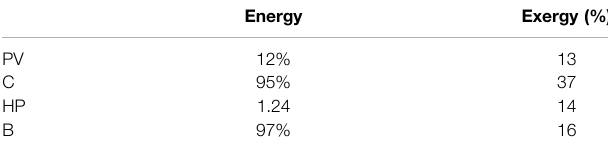
TABLE 2 | Energy and exergy ef fi ciency of generator